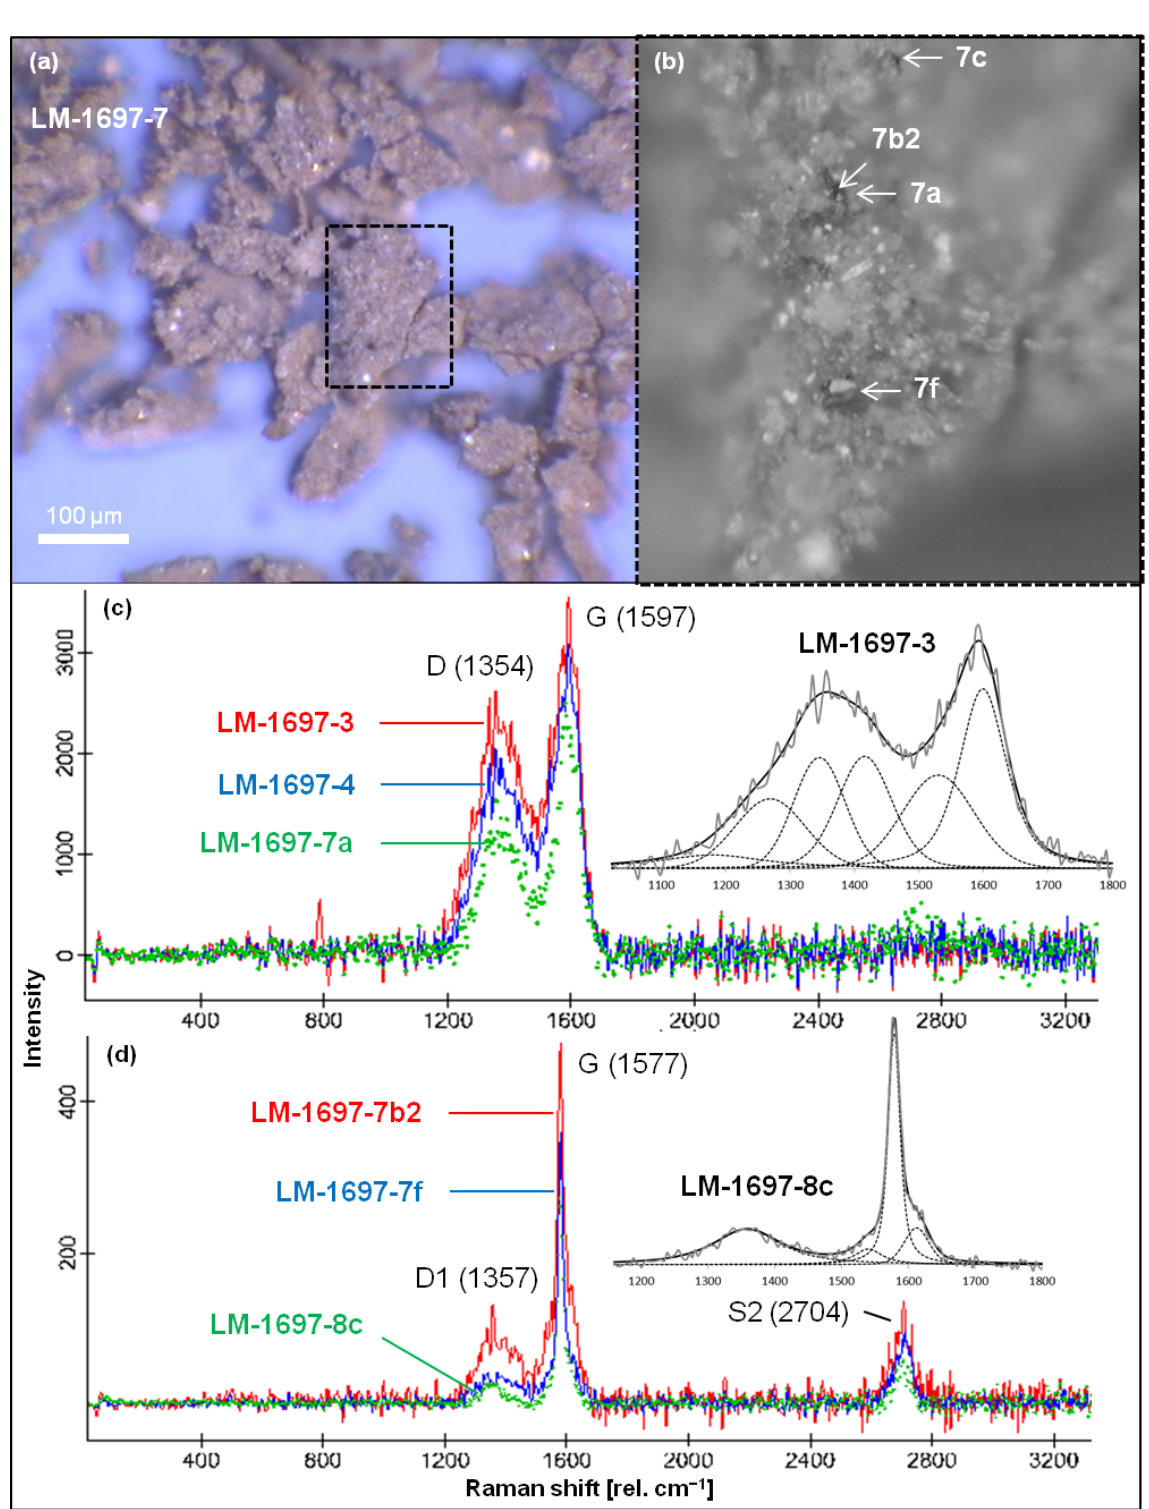
Figure 2. Raman spectroscopy of kerogen isolated from Green Bed chert sample LM-1697. (a) Kerogen flakes under reflected light. (b) Detail from ( a ; dashed box) showing selected spots analyzed via Raman (arrows). (c, d) Raman spectra obtained from several spots on the kerogen flakes, including those denoted in (b) ; insets magnify the spectral range of ca. 1100–1800rel.cm − 1 and show fits representative for kerogen populations (band order in c : S, Dl, D, Dr, Gl, G; Rebelo et al., 2016; band order in d : D1, D3, G, D2; Beyssac et al., 2002). Note the close spatial association of kerogen populations of low (immature; c ) and high thermal maturity (graphitic; d ) within the same